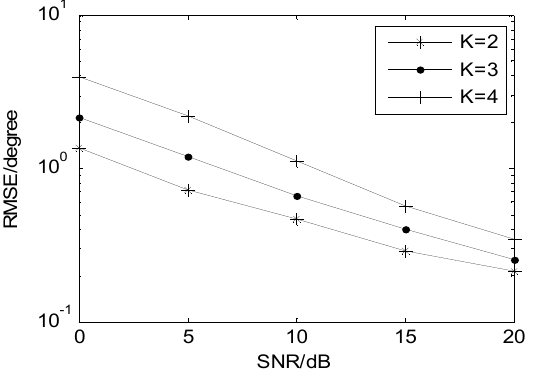
Figure 9. Angle estimation performance of our algorithm with different K ( M = 12, and J =